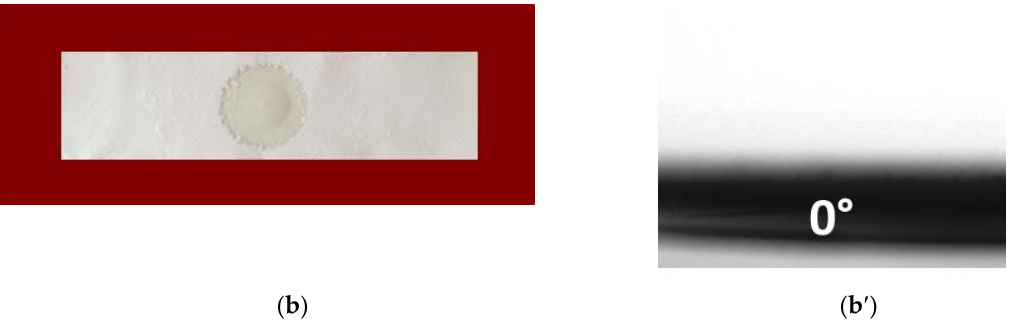
Figure 3. Images of distilled water droplets deposited on the surface of mats: ( a ) and ( a ). CA; ( b ) and ( b ). CA/PEG/QUE.